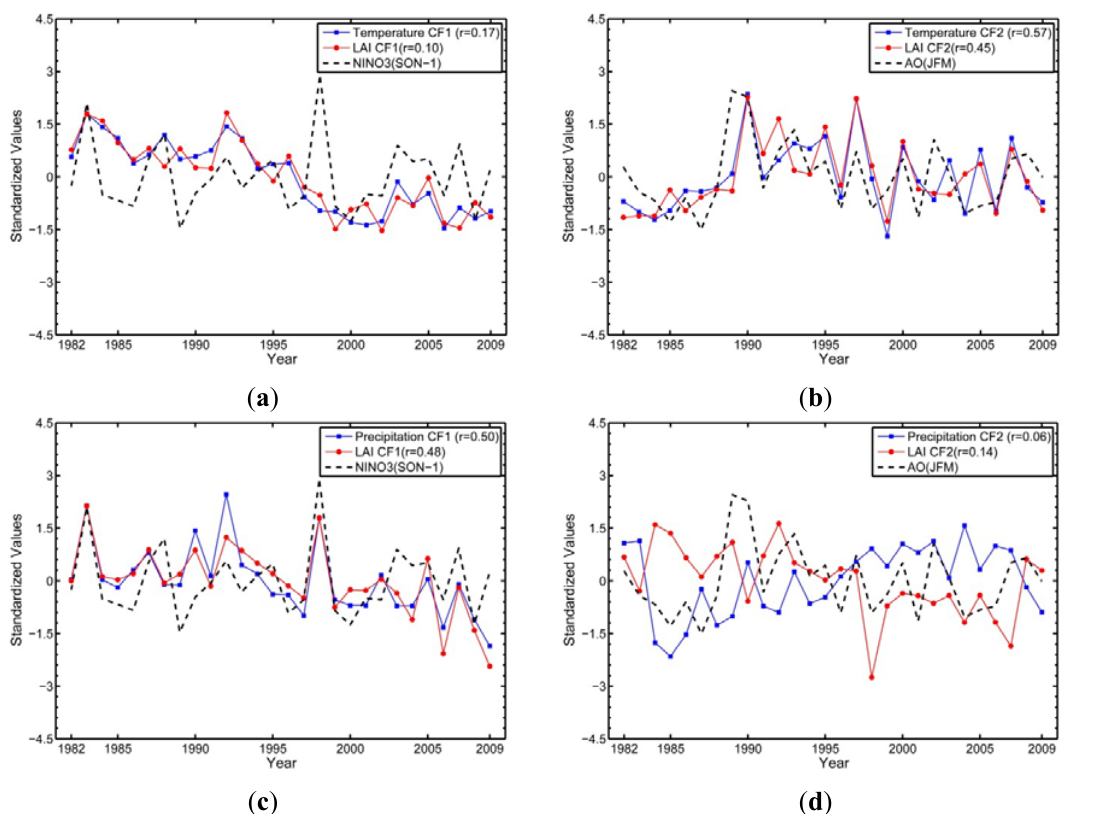
Figure 6. Correlations between the standardized time series of the first and second canonical factors (CF1 and CF2) of land surface temperature, precipitation and LAI3g with NINO3 and AO indices in the northern (10°N to 90°N) and tropical/extra-tropical regions (40°S to 40°N) for the period 1982 to 2009. The standardized September through November average NINO3 index time series of the preceding year and the January through March average AO index are shown in these plots as black dash